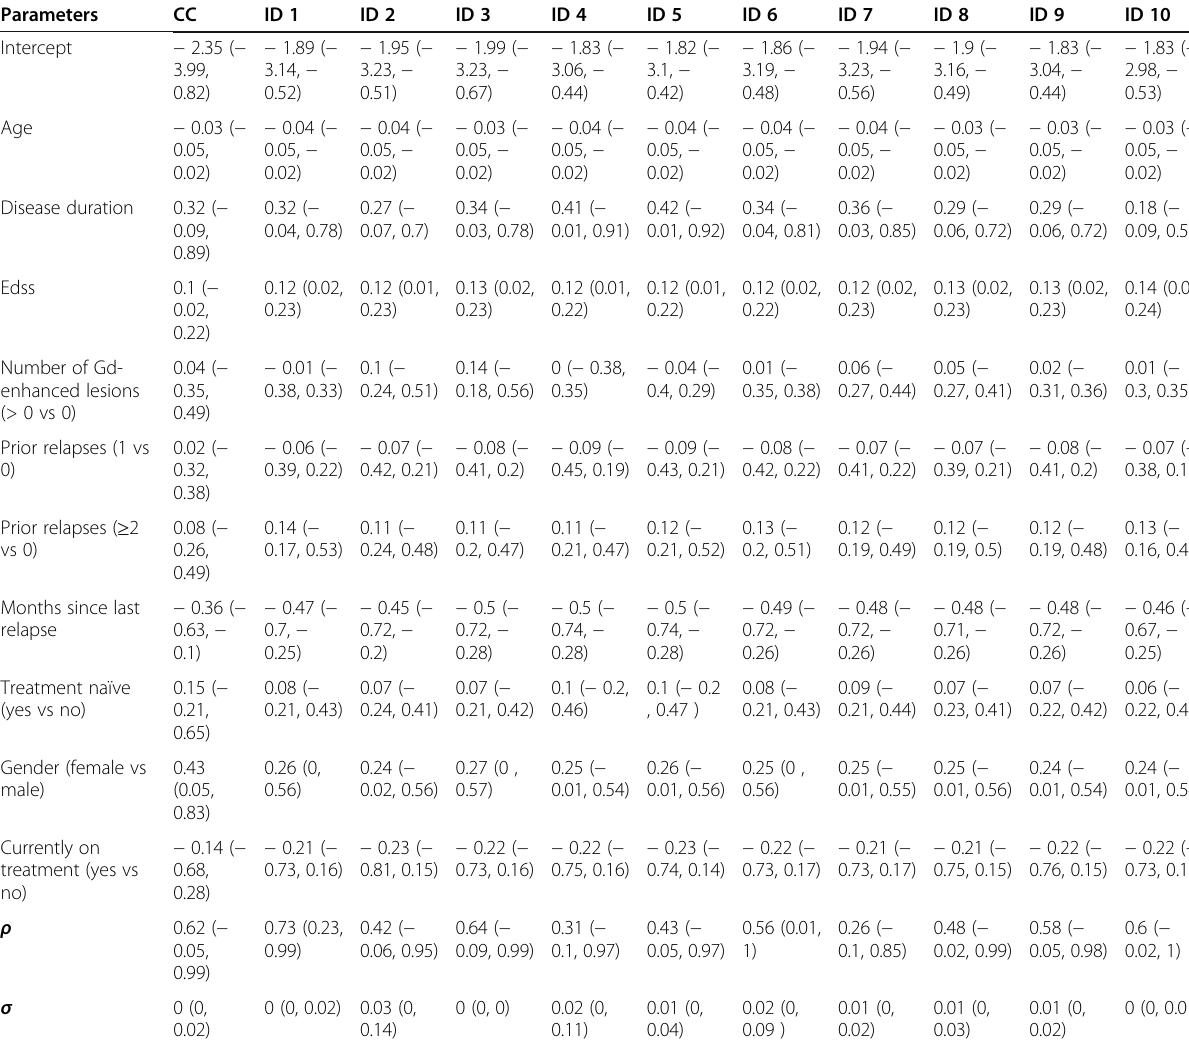
Table 6 The estimation of all parameters in the complete dataset and in each one of the imputed datasets Parameters